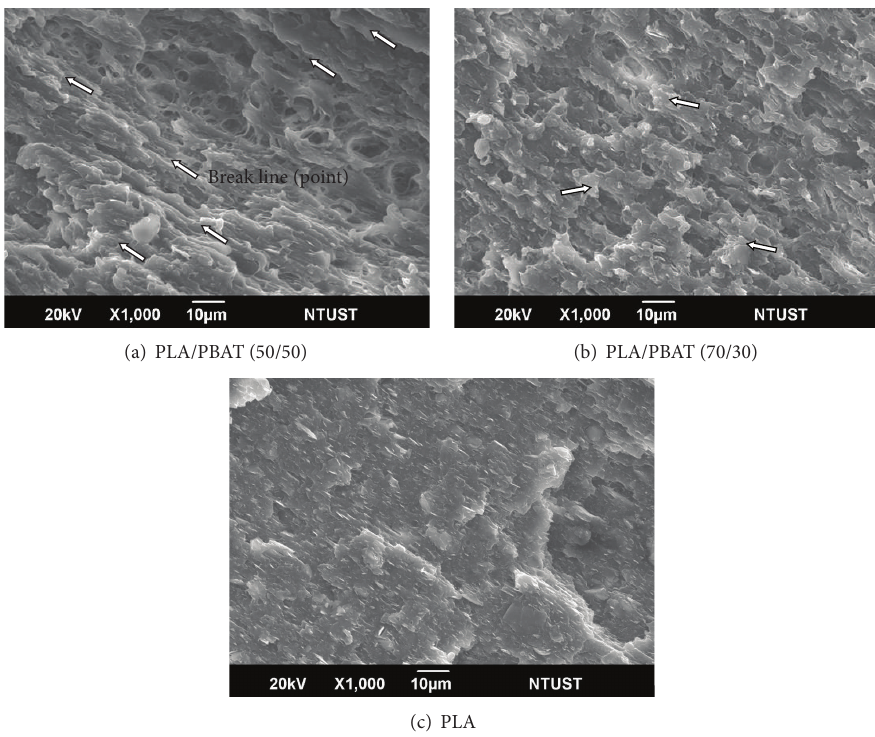
Figure 9: SEM micrographs of impact fractured at room temperature. The white arrows in (a-b) point to the break tracks.